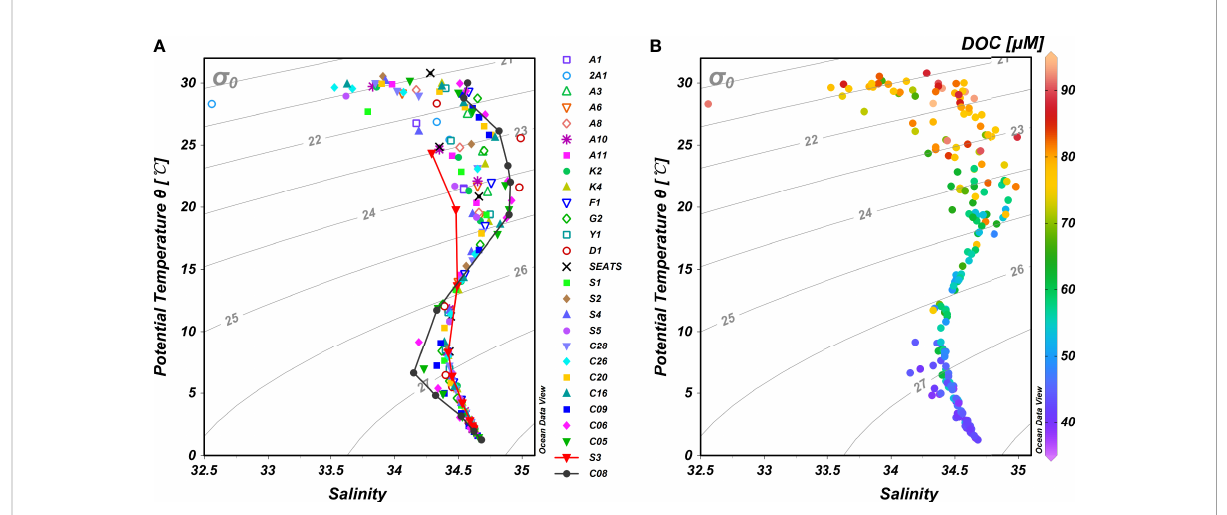
FIGURE 3 Plots of (A) potential temperature versus salinity ( T - S ) alone and (B) superimposed by observed DOC concentrations at stations in the northern SCS and western NP measured during three cruises (2015, 2016 and 2019). The s 0 isolines (gray) are included in the fi gures. The colored symbols in panel (A) correspond to CTD data, and solid lines (red and black) designate the representative T-S properties of the SCS and Kuroshio Current at stations S3 and C08, respectively (Ding et al., 2020). All fi gures were generated using ODV (Schlitzer,